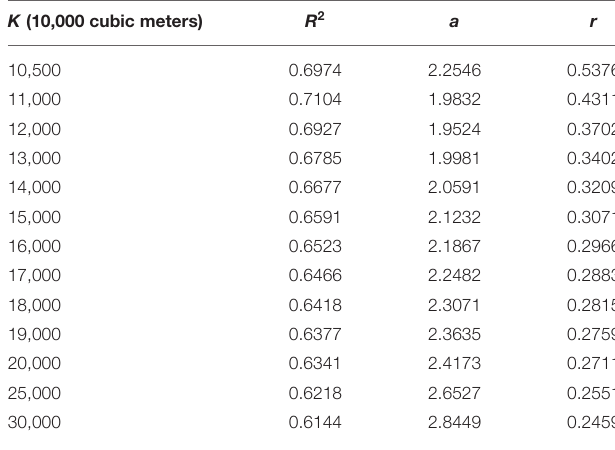
TABLE 2 | Regression analysis of a and r in Fuyang City for the next 10